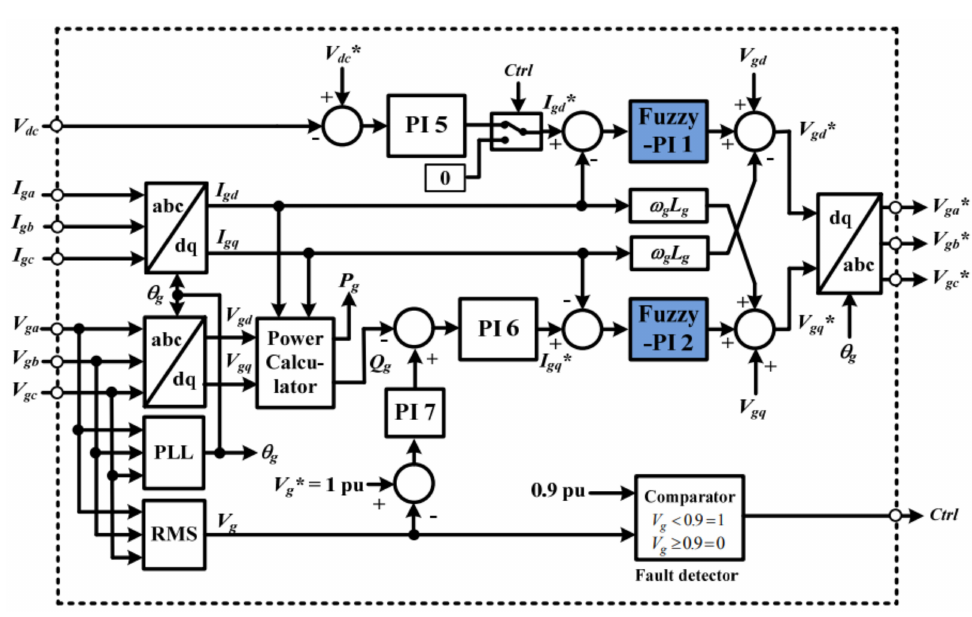
Figure 6. The grid side converter control of the